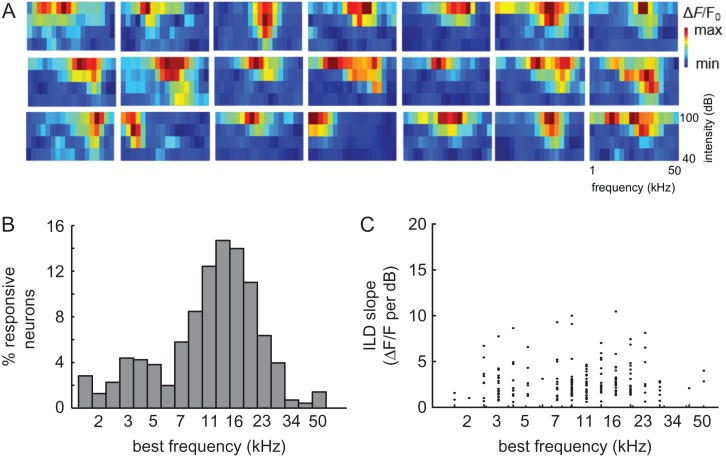
Local spatial distribution of BFs. (A) Frequency response areas from a sample of 21 neurons imaged in the 6 mice shown in Figures 6B and 7B. (B) BF distribution for all neurons in the dataset. (C) Steepest ILD response function slope of each neuron plotted as a function of its BF.